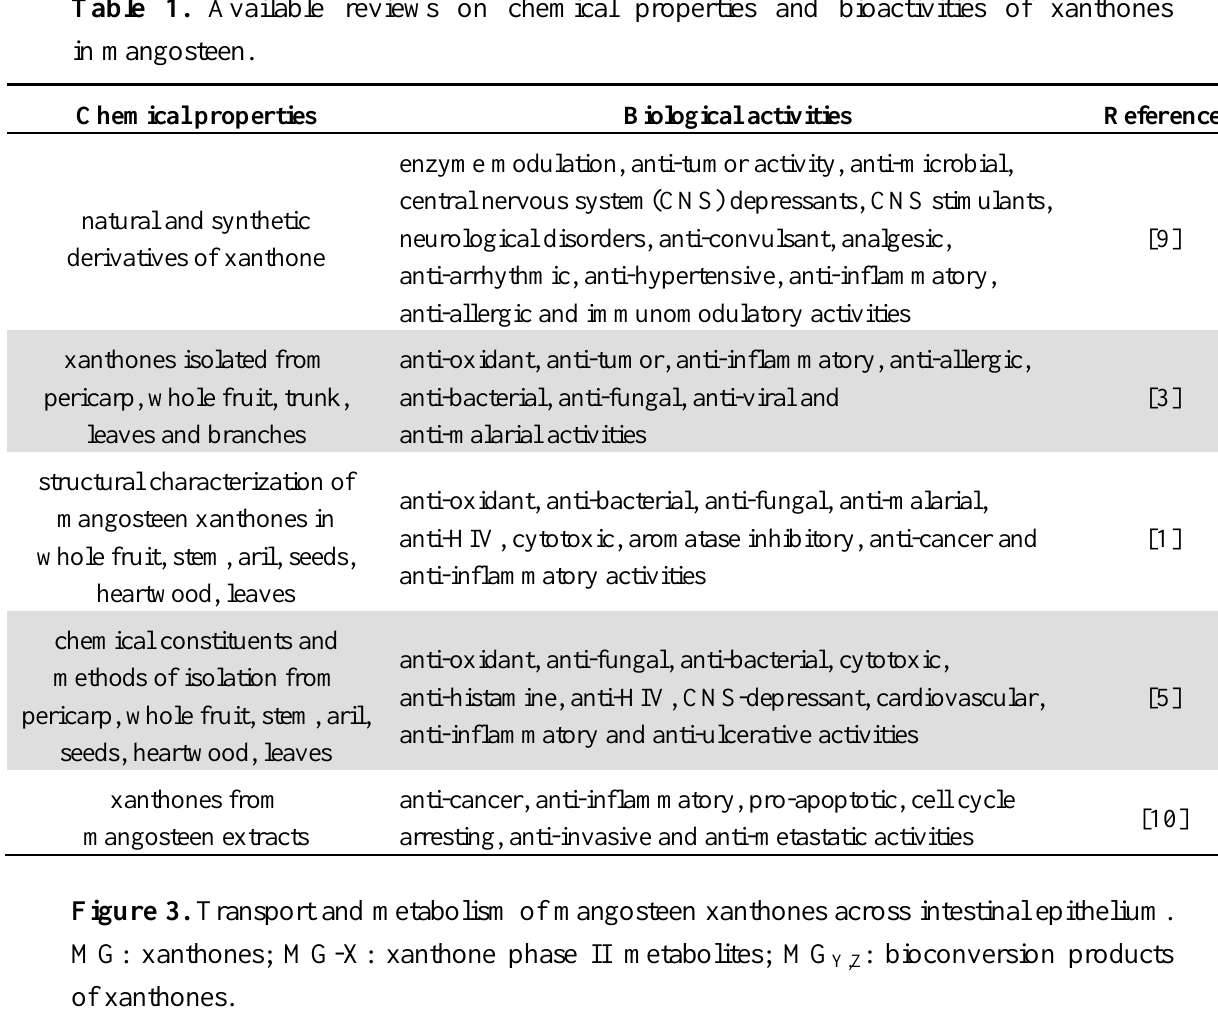
: bioconversion products Y,Z